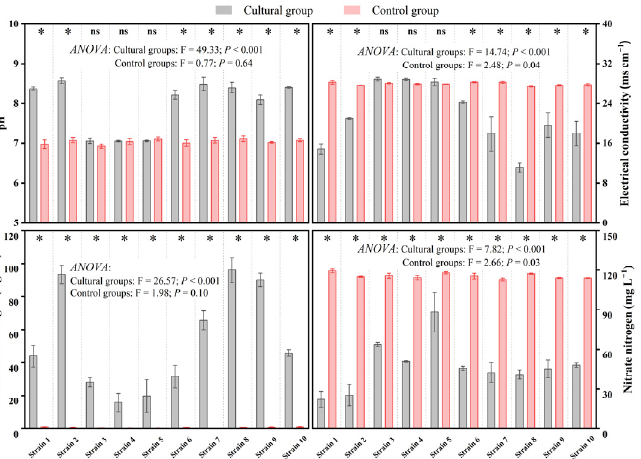
Figure 4. Physicochemical properties of the culture media. The asterisk indicates significant difference between the culture and control groups; ns indicates not. ANOVA, Analysis of